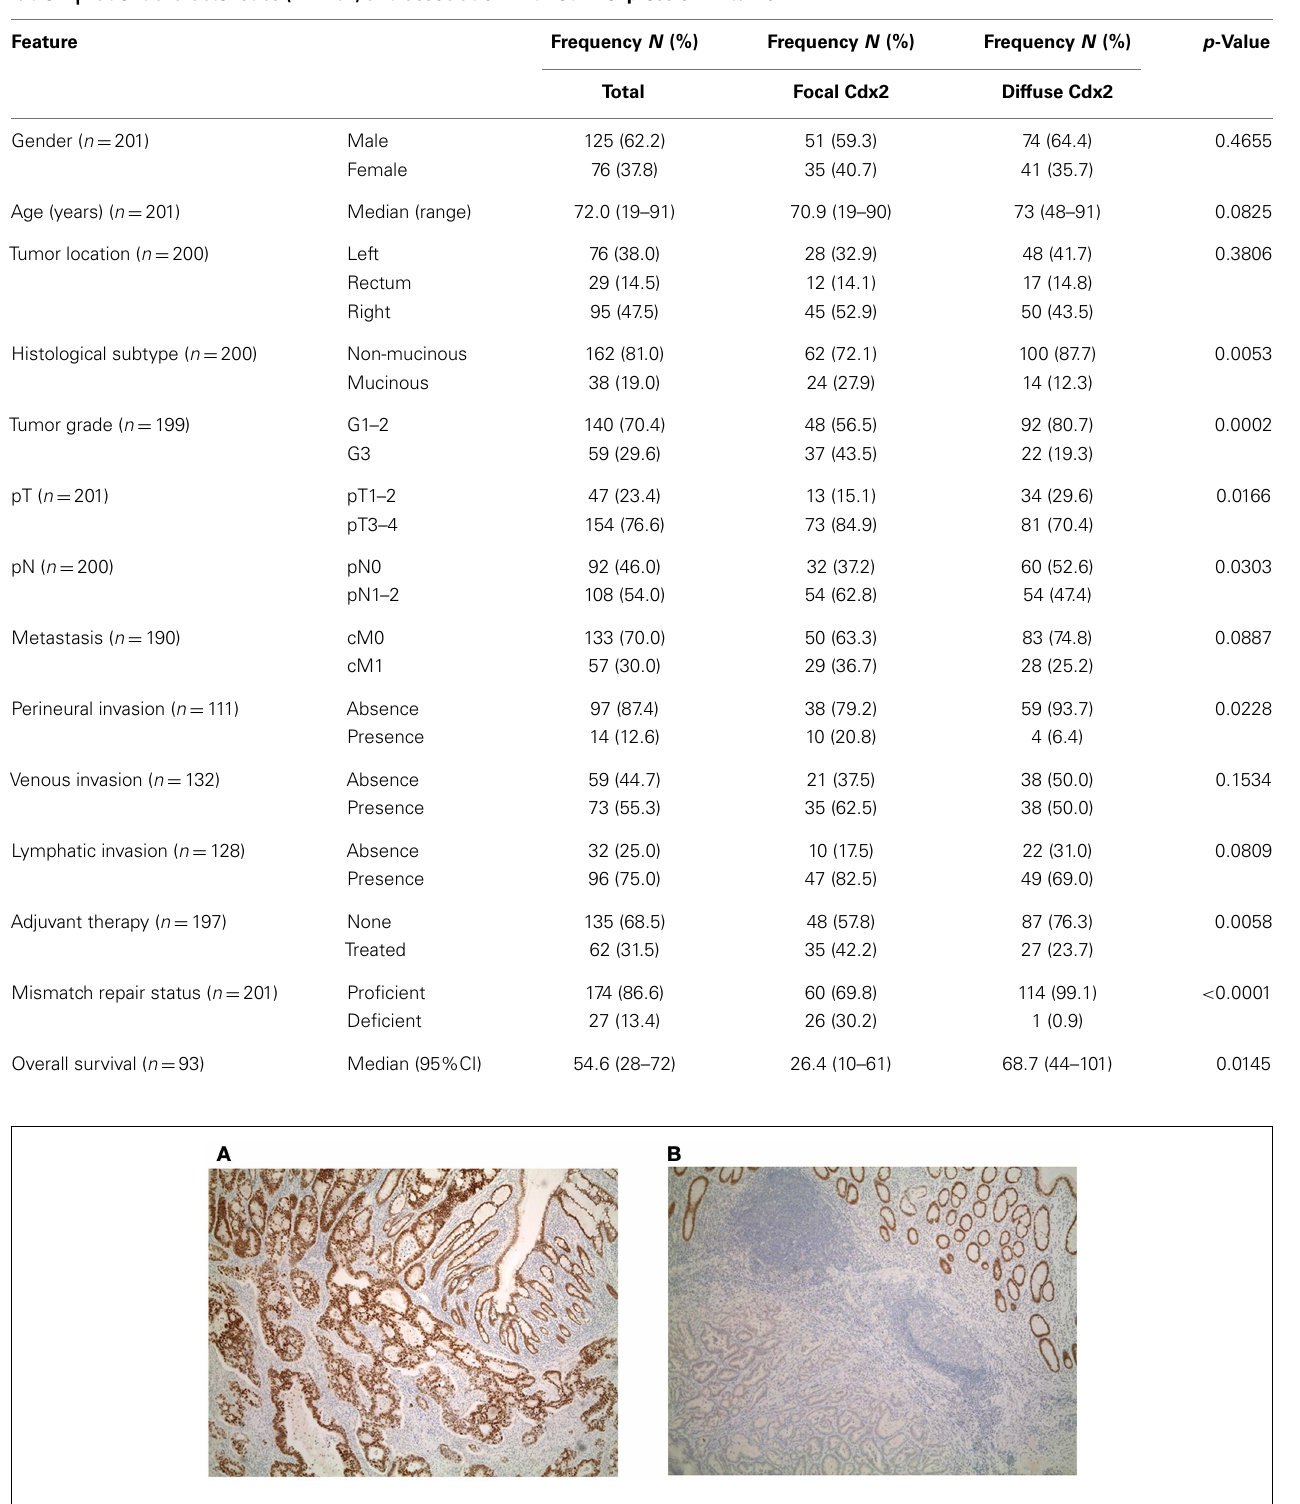
Table 1 | Patient characteristics ( n = 201) and association with Cdx2 expression in tumor.